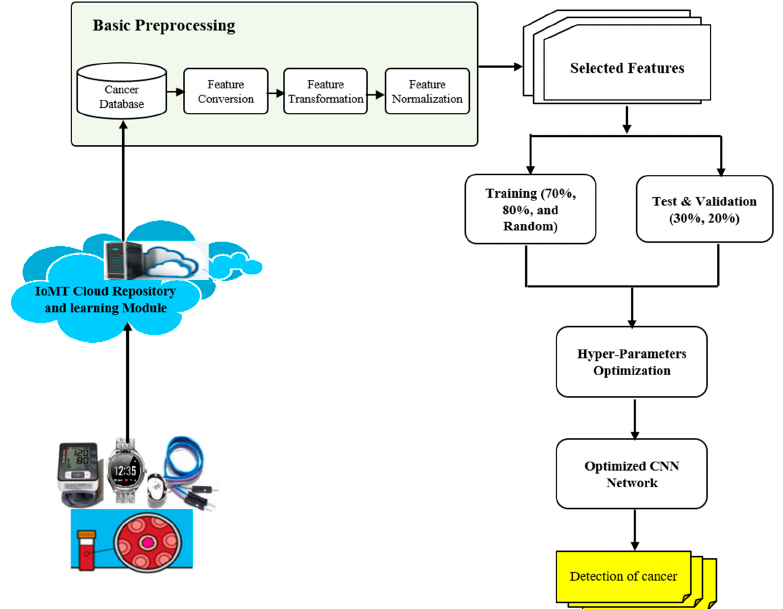
Figure 2. The proposed framework for the IoMT-based cancer diagnostics system.